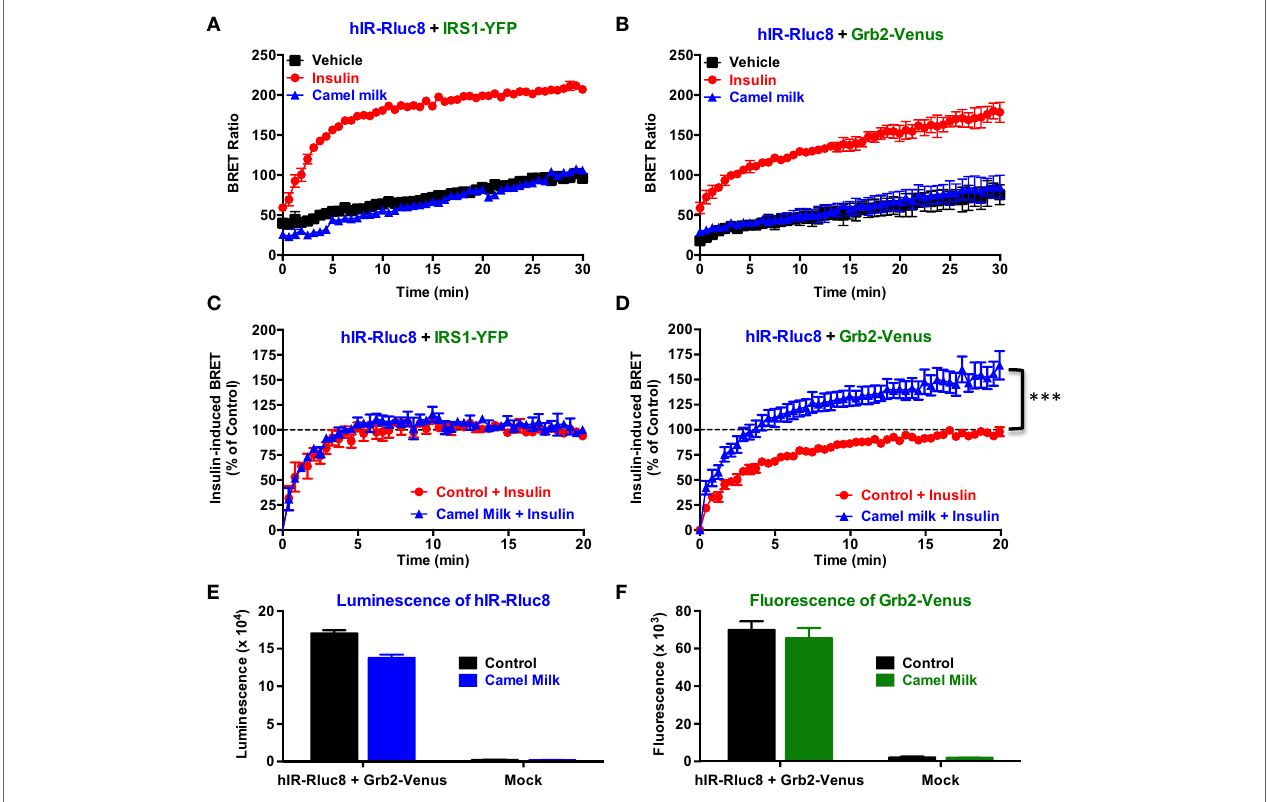
FigUre 2 | effect of camel milk on BreT between hir–rluc8 and its signaling proteins. HEK293 cells transiently co-expressing hIR–Rluc8 and either IRS1–YFP (a,c) or Grb2–Venus (B,D–F) were first pre-treated (blue triangle) or not (black square and red circle) 30 min with camel milk before BRET measurements were performed in the absence or presence of stimulation with 100 nM of insulin as indicated. In parallel, luminescence (e) and fluorescence (F) analysis were carried out to quantify the relative expression of hIR–Rluc8 and Grb2–Venus, respectively. In (c,D) , insulin-induced BRET signals in cells not pre-treated with camel milk (red circle) were normalized to 100%. Data are mean ± SEM of 3–10 independent experiments performed in